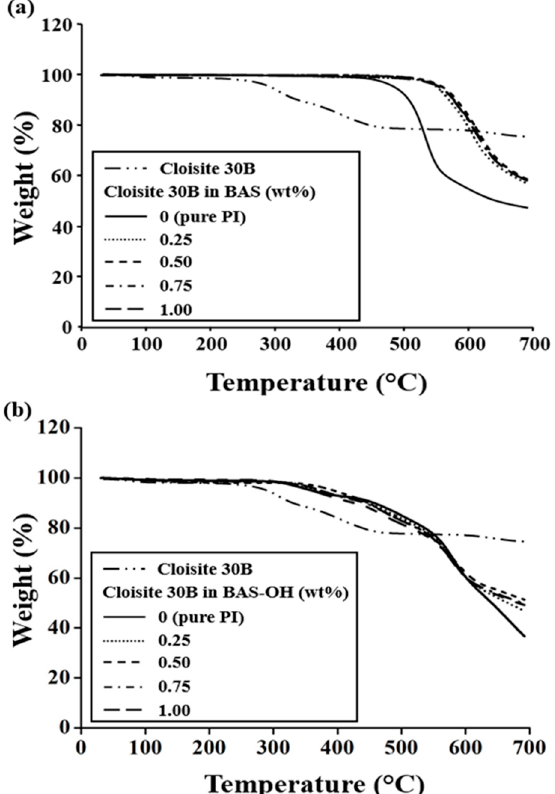
Figure 8. TGA thermograms of PI hybrid films with various organoclay contents: ( a ) BAS and ( b ) BAS-OH.